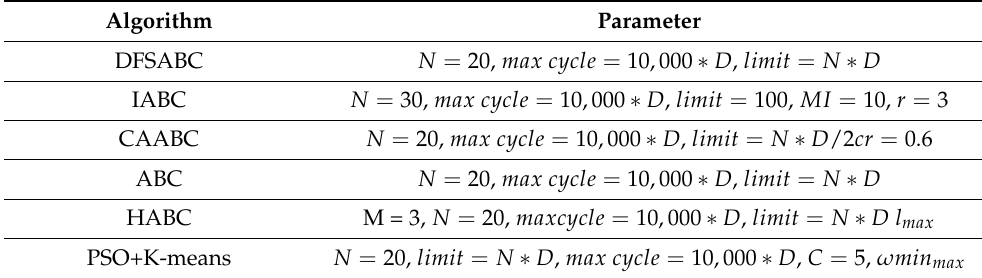
Table 2. Parameter Setting.